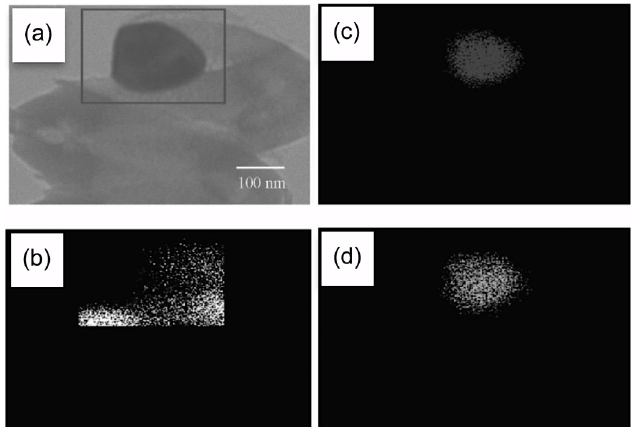
Figure 14. EDS mapping of ( a ) one single helical CNC and the tip nanoparticle; and images showing the elemental distribution of ( b ) carbon; ( c ) iron; and ( d ) tin [46]. Reprinted with permission from [46], Copyright 2008 John Wiley and